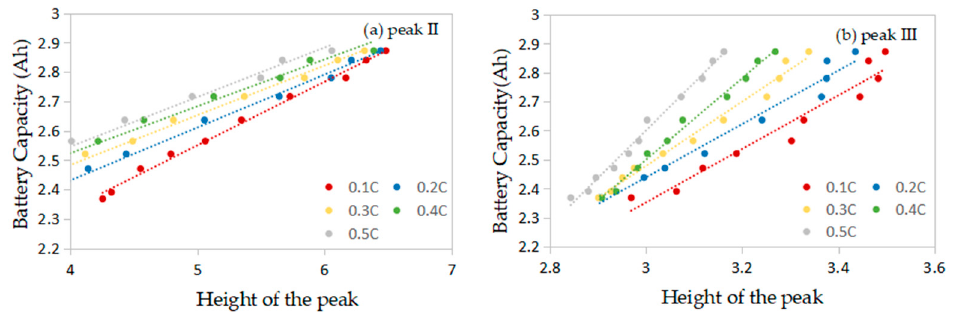
Figure 3. The correlation between the features of IC curves and battery capacity: ( a ) peak II; ( b ) peak III.